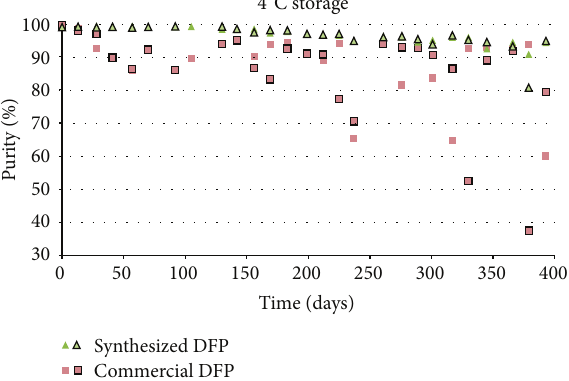
Figure 5: Purity results for synthesized DFP and commercial DFP when stored at − 80 ∘ C.